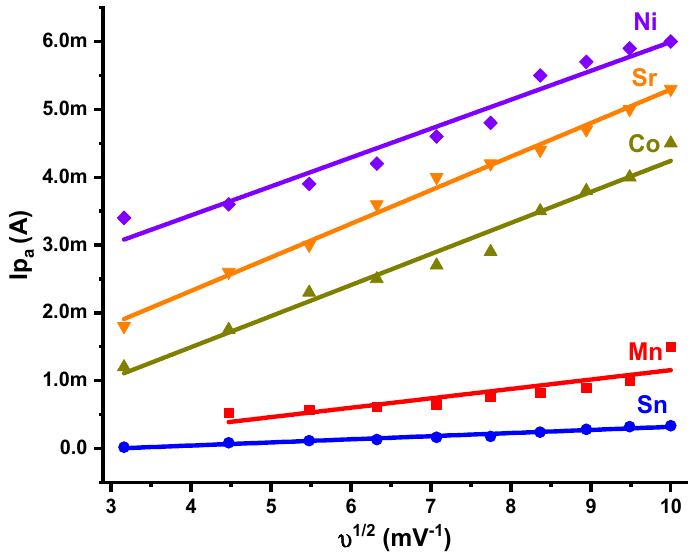
Figure 11. Dependence of Ip a on υ 1/2 showing linear fitting for scan rates for g-C 3 N 4 /MetalWO 4 .